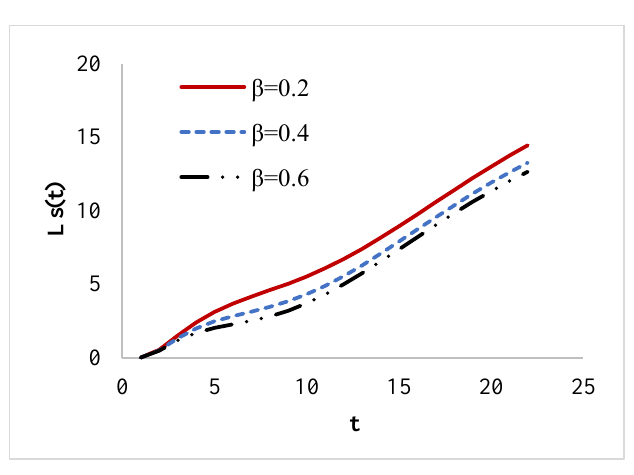
Figure 4. Effect of  on